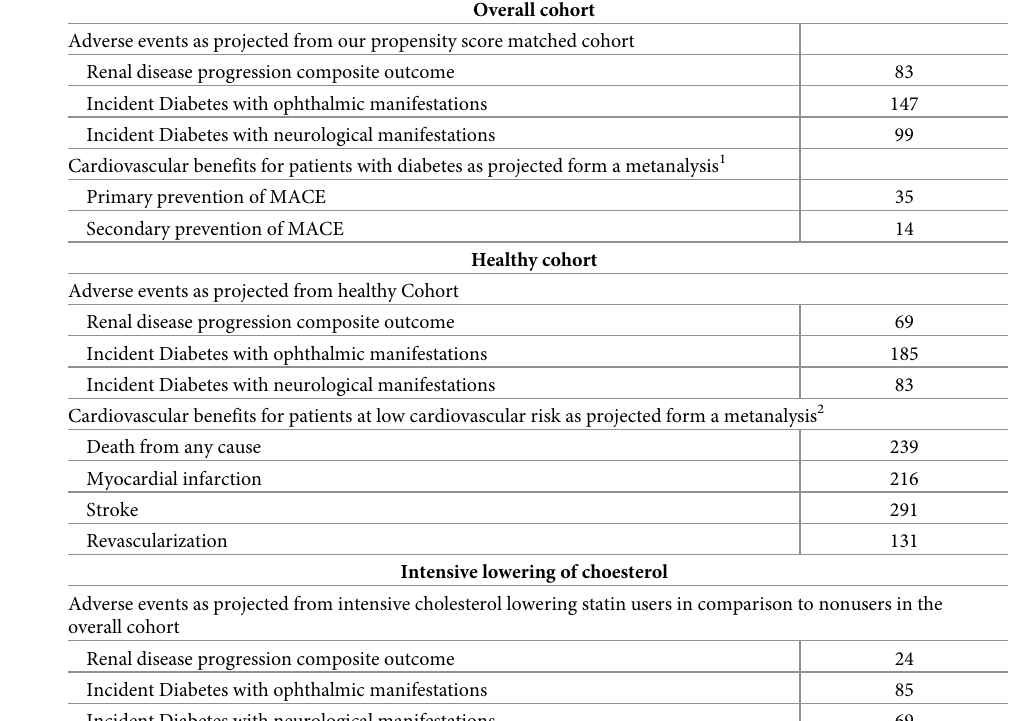
Adverse events as projected from our propensity score matched cohort Renal disease progression composite outcome